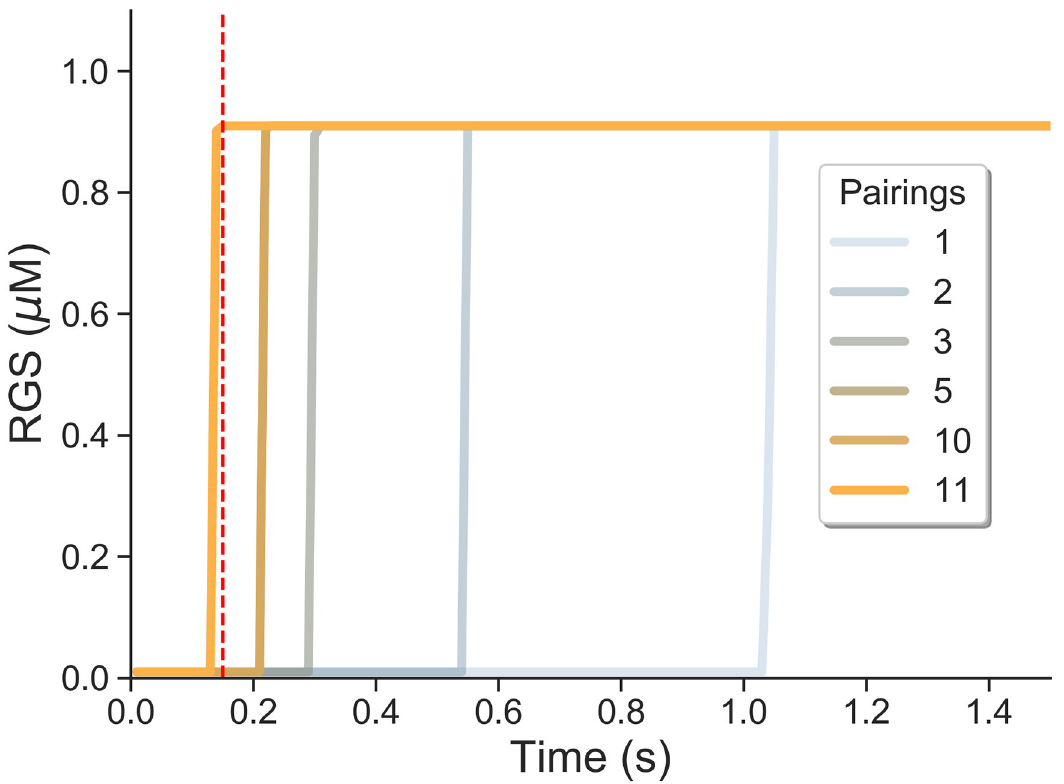
Fig 5. RGS protein learns to anticipate climbing fiber signal. Response of the model to delay eyeblink conditioning with an interstimulus interval of 150 ms. Red dashed line indicates the arrival of the climbing fiber input. Time course of RGS protein activation depends on the number of previous pairings. After training with 11 pairings protein activation anticipates climbing fiber input.